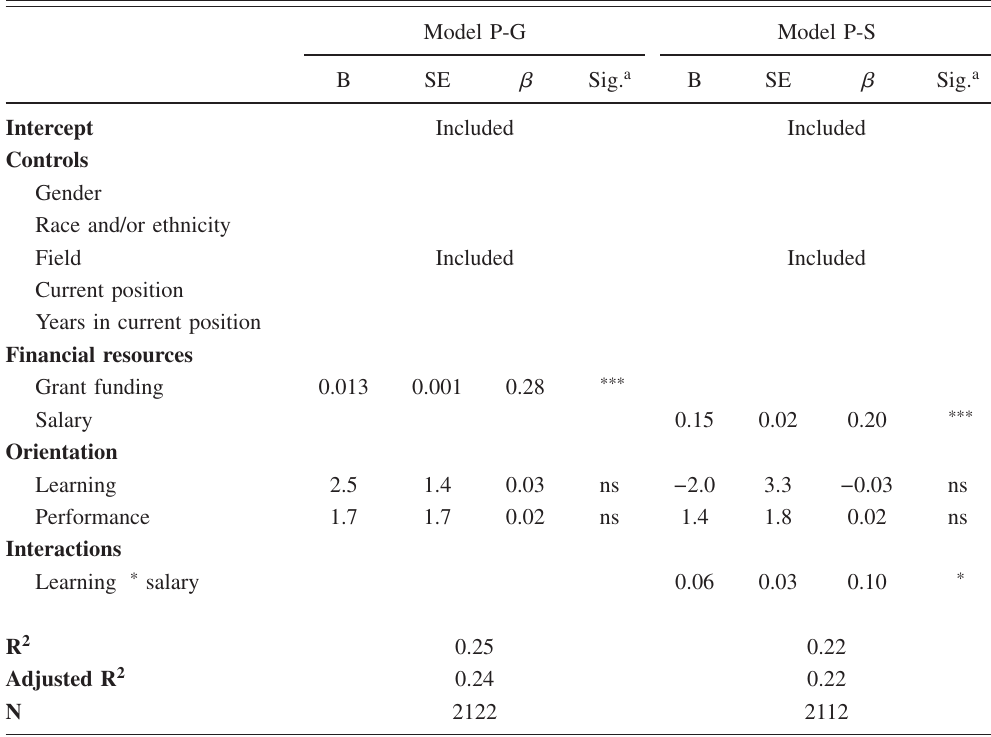
TABLE II. Multiple regression models with outcome of primary and/or first-author publications while accounting for grant funding (cid:1) Model P-G (cid:2) and salary (cid:1) Model P-S (cid:2) . Also considered were interactions of both goal orientations with grant funding and salary.